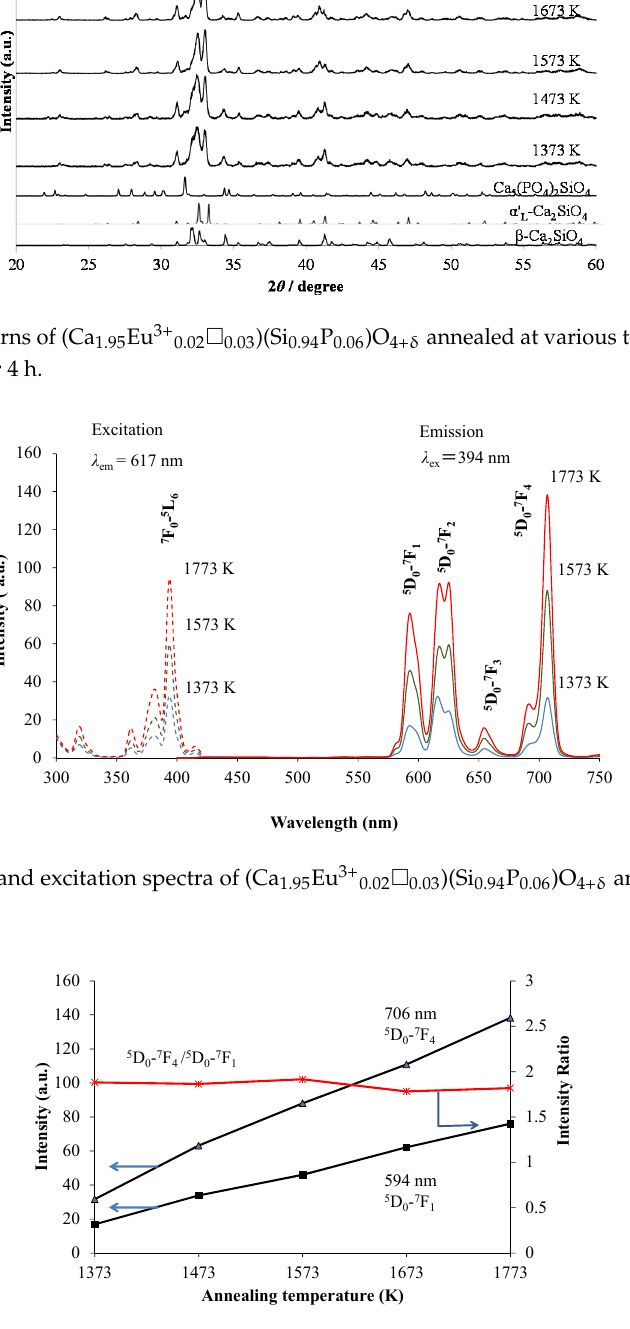
Figure 3. The emission intensities of (Ca 1.95 Eu 3+0.02 □ 0.03 )(Si 0.94 P 0.06 )O 4+ δ at 706 nm and at 594 nm excited by 394 nm. The ratio of I 706 nm/I 594 nm is also plotted.